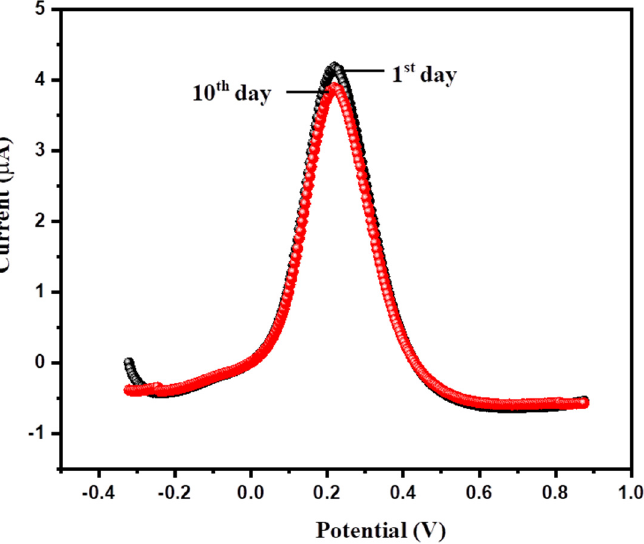
Figure 12. DPVs of MGCE (1st day and after 10th day) in 20 µM of serotonin in 0.1 M PBS (pH = 7.0) at scan rate of 50 mV/s.